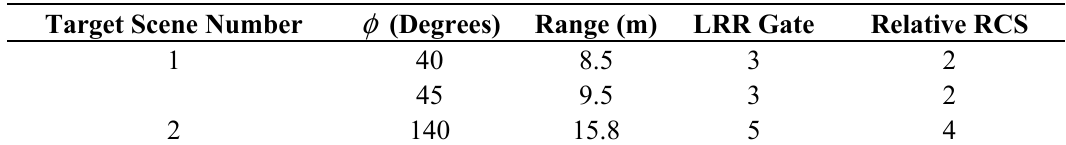
Table 8. Target Scenario 6.